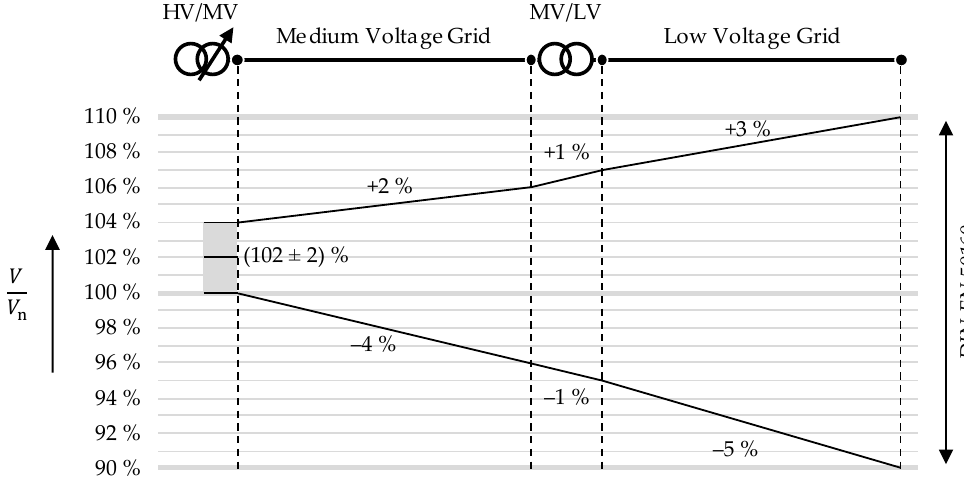
Figure 4. Assumed division of voltage range between medium voltage and low voltage grids.